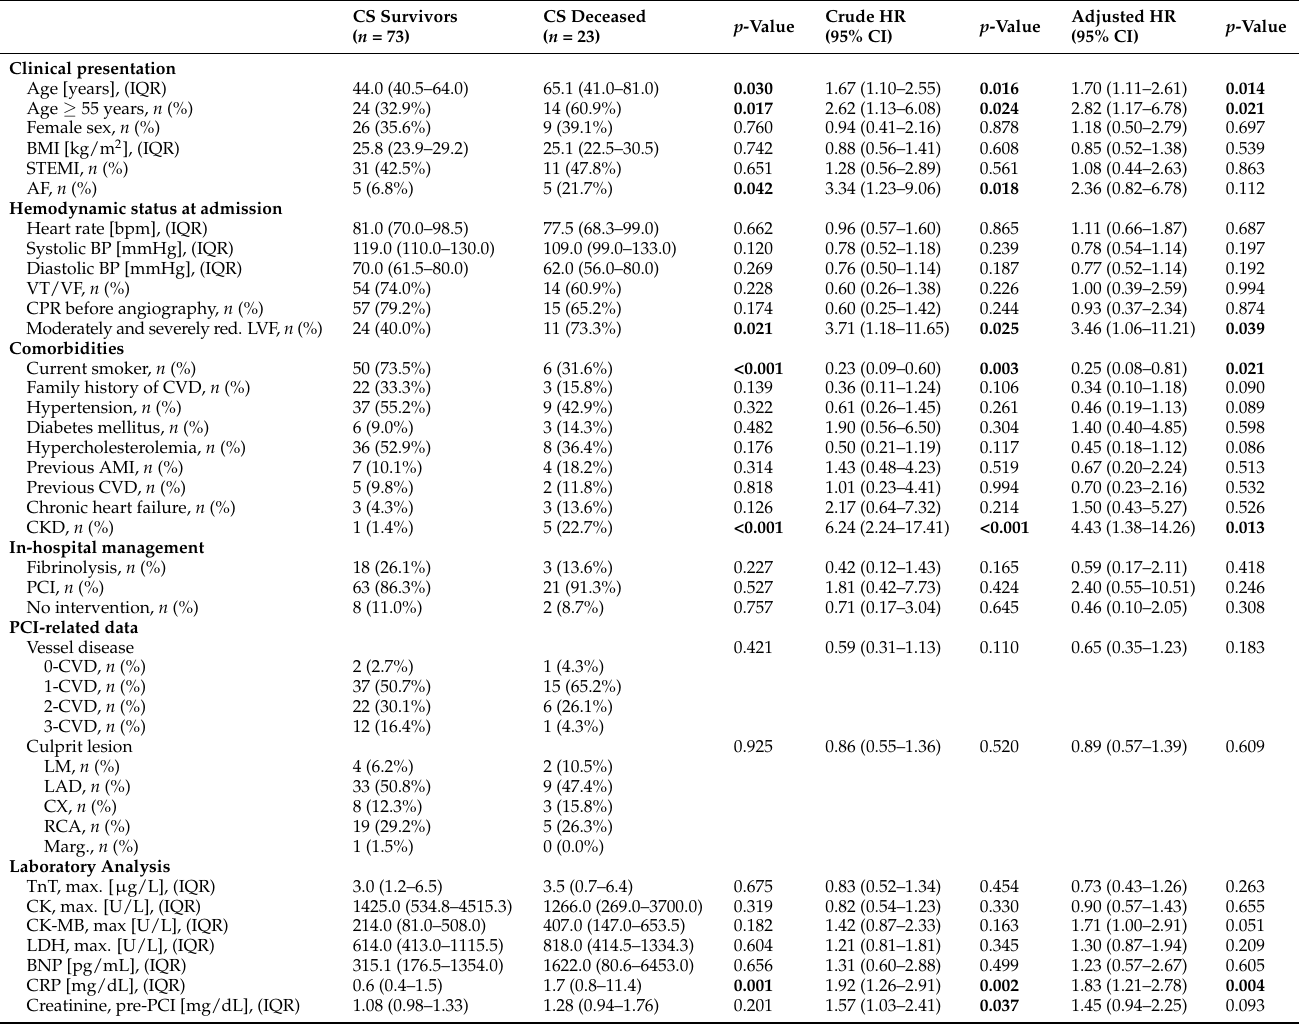
Table 4. Baseline characteristics with crude and adjusted hazard ratios on long-term cardiovascular mortality for cardiogenic shock